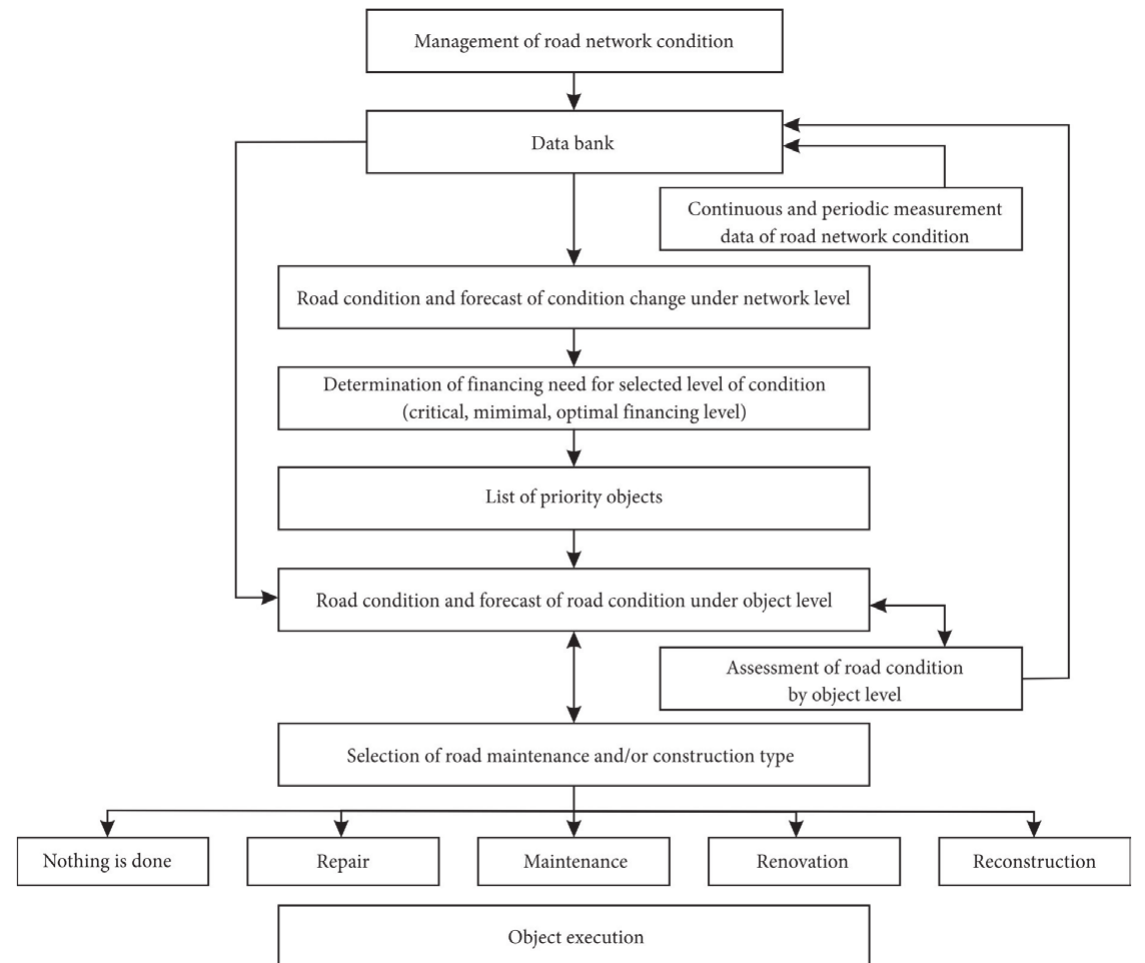
Fig. 7. Management system of road network